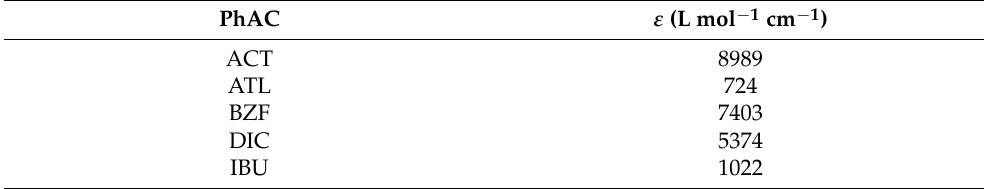
Table 4. Molar absorption coefficients ( ε ) of ACT, ATL, BZF, DIC and IBU at 254 nm and pH 2.